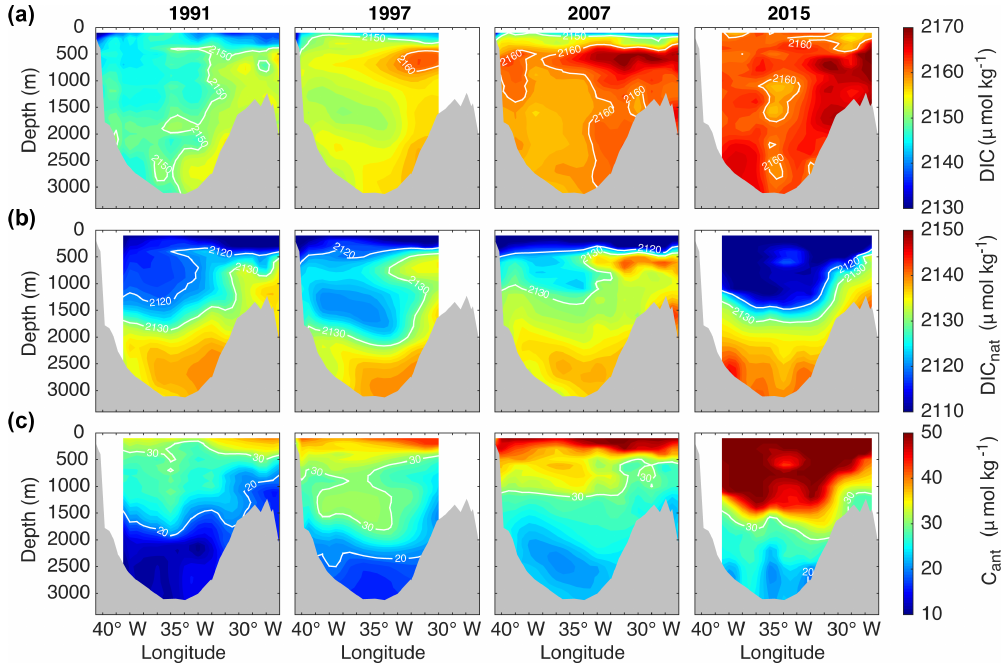
Figure 5. Vertical cross sections through the Irminger Sea showing interpolated cruise station data of (a) DIC, (b) DIC nat and (c) C ant concentration in 1991 (first column), 1997 (second column), 2007 (third column) and 2015 (last column). The white contour lines illustrate selected concentration levels. All panels have the same span of values of 40µmolkg − 1